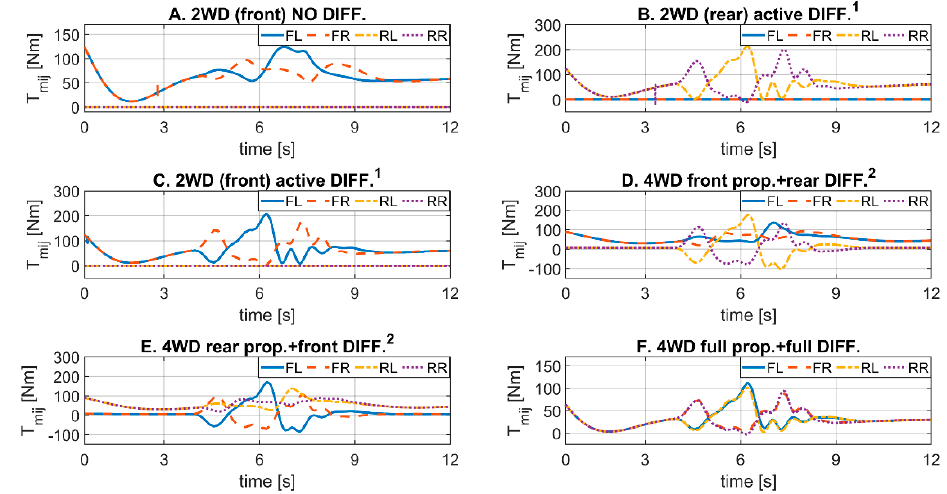
Figure 14. DLC Maneuver: 4IWM torques coordination: ( A ) 2WD (front) NO DIFF.{ 𝑑⃗ ((cid:3032)) }; ( B ) 2WD (rear) active DIFF.{ 𝑑⃗ ((cid:3029)) }; ( C ) 2WD (front) active DIFF. { 𝑑⃗ ((cid:3034)) }; ( D ) 4WD front prop.+rear DIFF. { 𝑑⃗ ((cid:3033)) }; ( E ) 4WD rear prop.+front DIFF. { 𝑑⃗ ((cid:3030)) }; ( F ) 4WD full prop.+full DIFF.{ 𝑑⃗ ((cid:3039)) }. [ 1 (B{ 𝑑⃗ ((cid:3029)) },C{ 𝑑⃗ ((cid:3034)) }) and 2 (D{ 𝑑⃗ ((cid:3033)) },E{ 𝑑⃗ ((cid:3030)) }) are dual layouts].